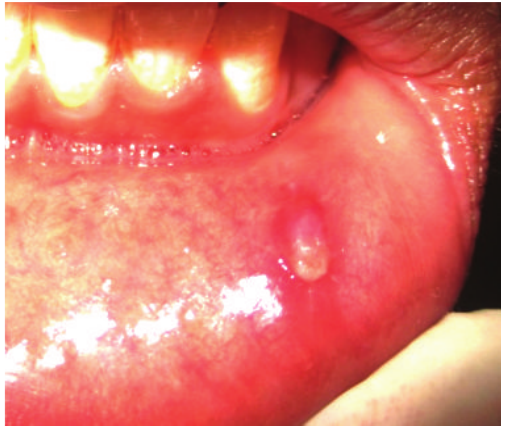
Figure 3: Healing areas seen post-operatively after 10